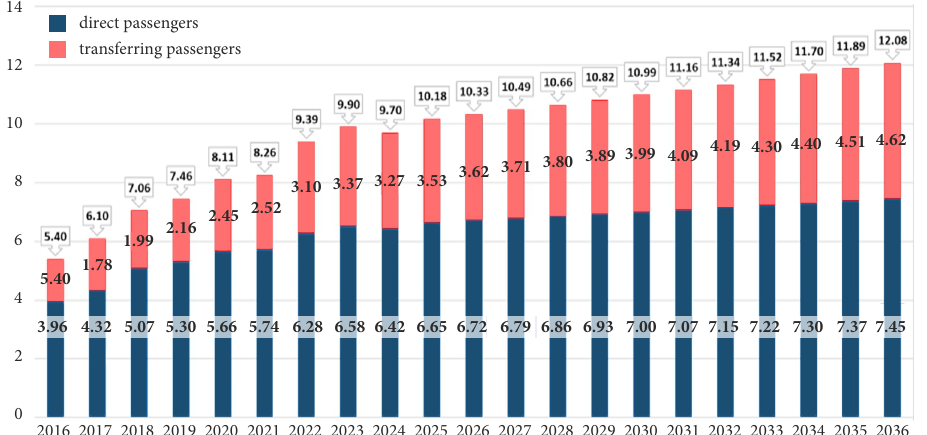
Figure 3. Passenger flow forecast (RIX